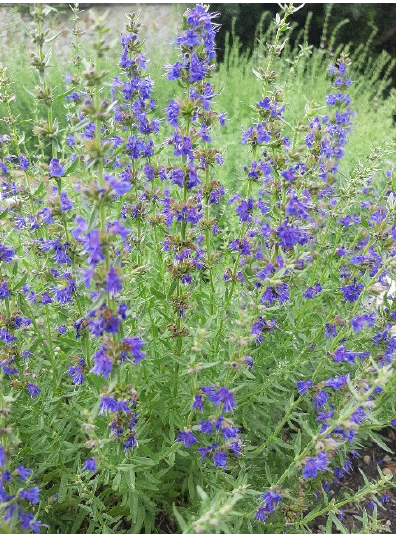
Figure 2. Selected perspective specimen of Hyssopus officinalis f. cyaneus Alef.